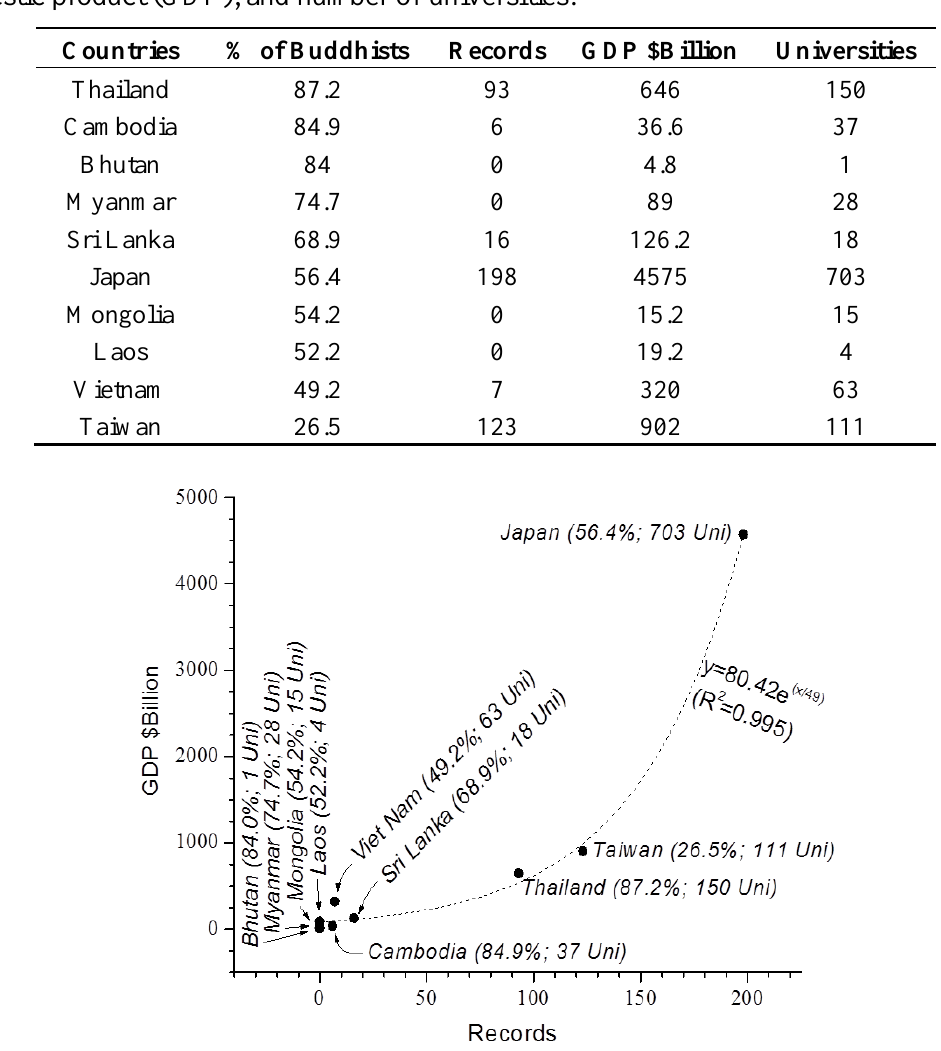
Table 9. Top 10 countries with the highest percentage of Buddhists [7], research productivity as number of records in the field of Buddhism and Buddhist studies from 1993 to 2011, gross domestic product (GDP), and number of universities.